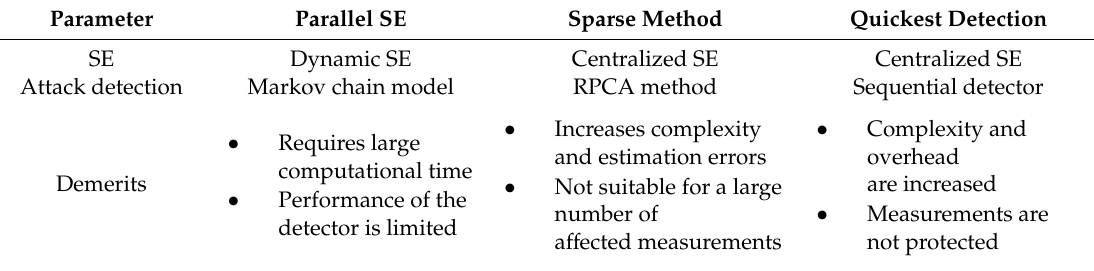
Table 4. Analysis on previous works.